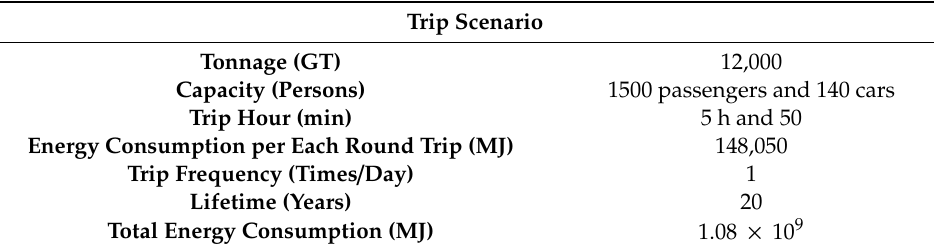
Table 5. Engine and fuel cell with motor specifications in the Tank-to-Wake stage.